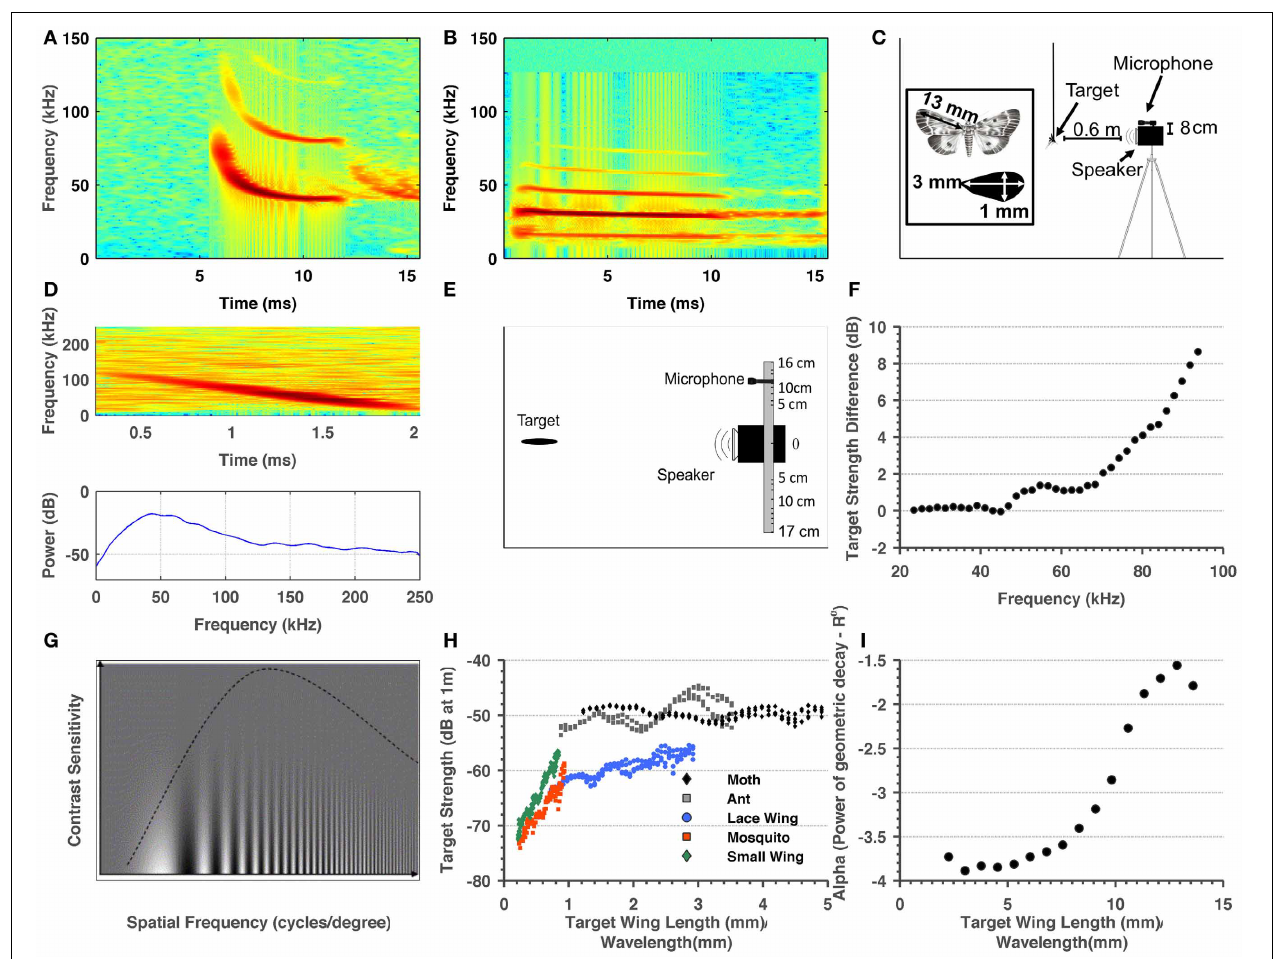
FIGURE 1 | Summary of methods and target-related parameters measured in order to estimate visual and echolocation detection ranges. (A) Spectrogram of a typical P. kuhlii search call. (B) Spectrogram of a typical R. microphyllum search call. (C) Sketch of the ensonification setup. (D) Spectrogram and spectrum of a single ant echo. (E) Sketch of the setup used to measure the directionality of the insects. (F) Target strength difference between the sweep echo returning directly (microphone at 0 ◦ relative to emitter) and returning from an angle corresponding to 8cm difference in position between center of